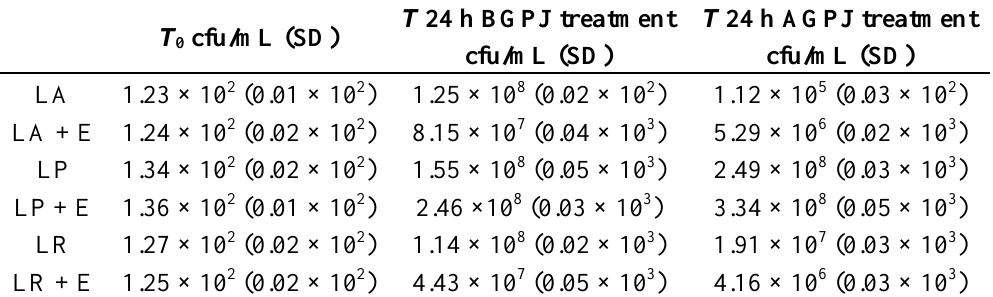
Table 1. Viability (expressed as cfu/mL) of L. acidophilus (LA), L. plantarum (LP) and L. rhamnosus (LR) grown in MRS medium (see materials and methods) without (used as the control) or with E. sativa (+E), before the in vitro gastric and pancreatic transit (BGPJ and AGPJ, respectively). The data are the mean (±standard deviation) of three independent